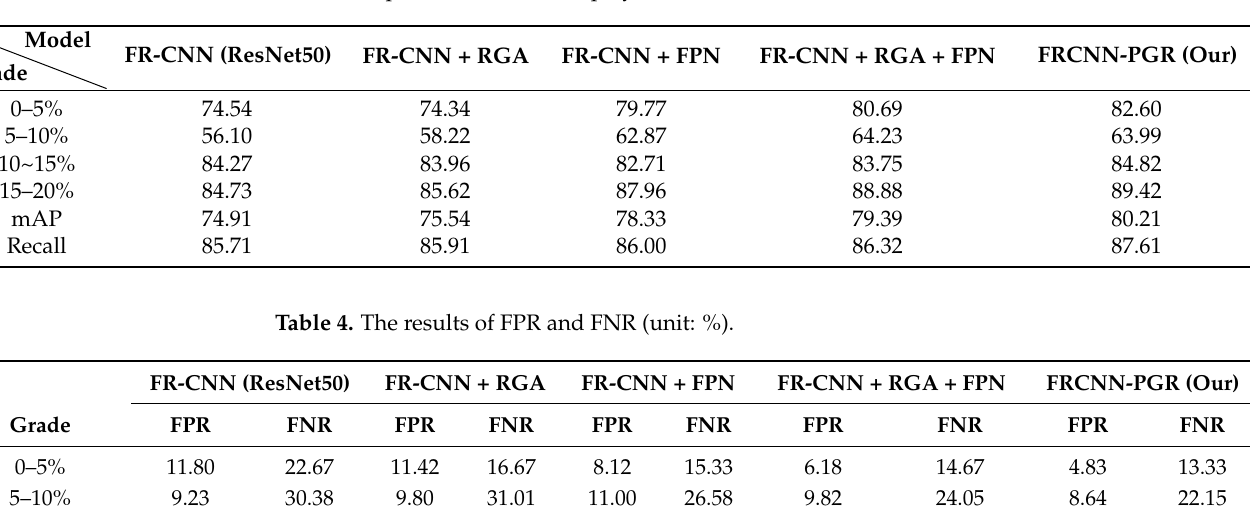
Table 3. Experimental result display (unit: %).